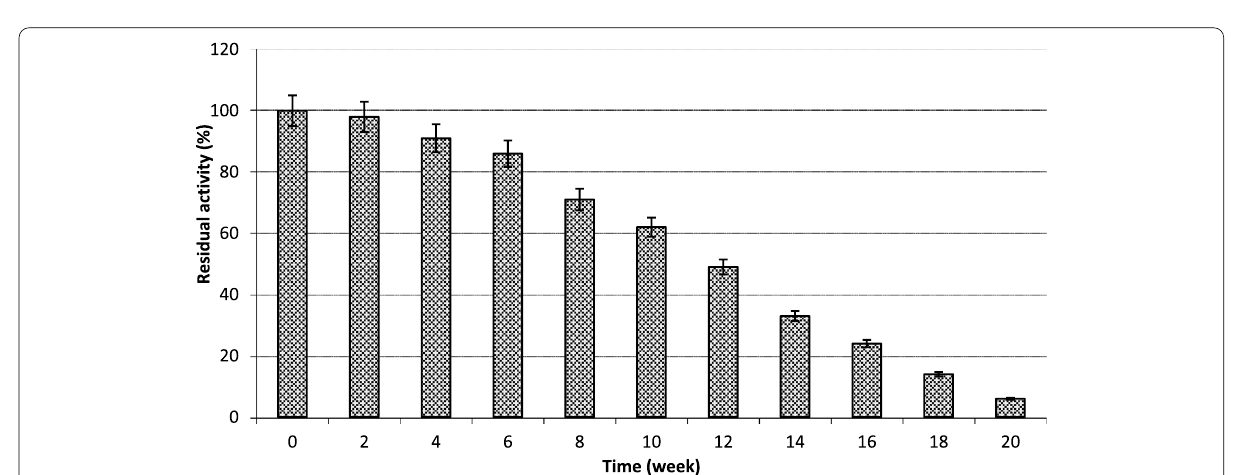
Fig. 7 Effect of thawing on recombinant cellSNSY enzyme